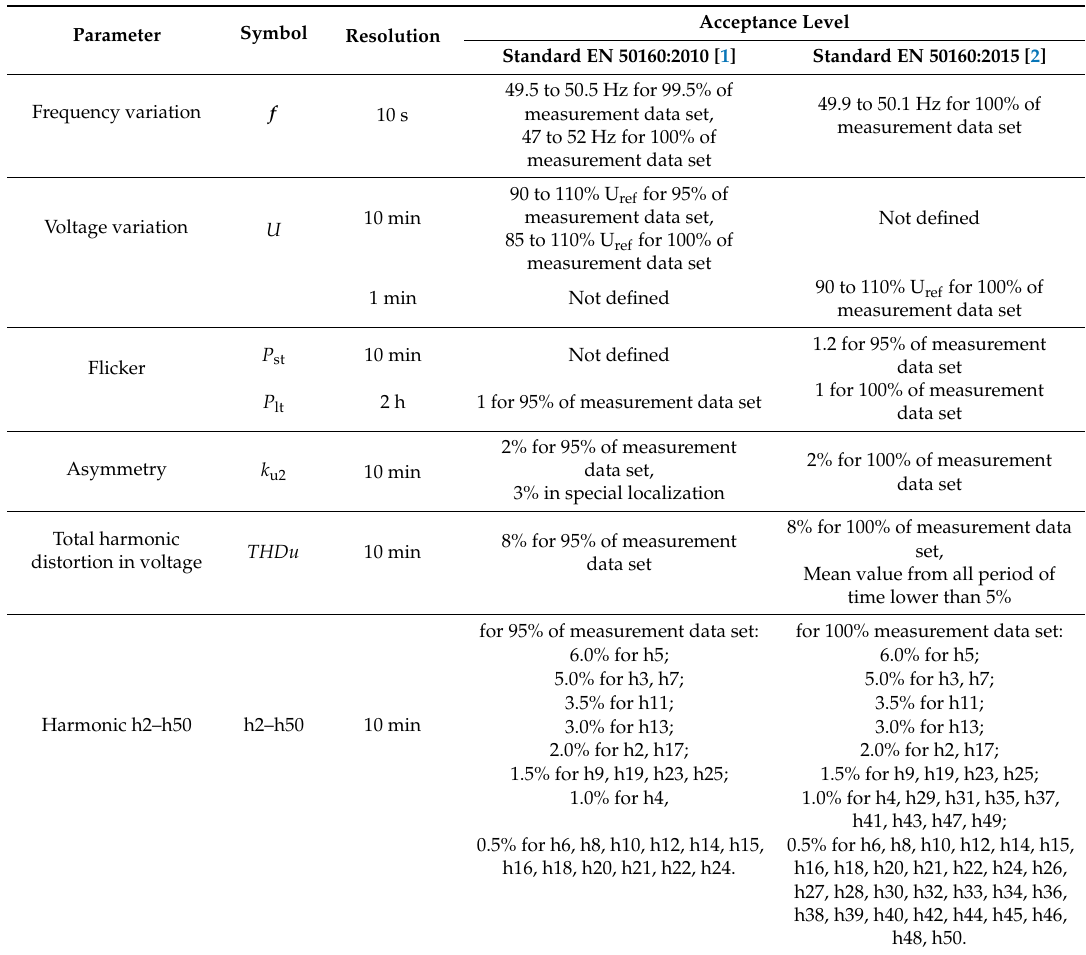
Table 1. Comparison of permissible levels of power quality parameters in EN 50160:2010 [1] and